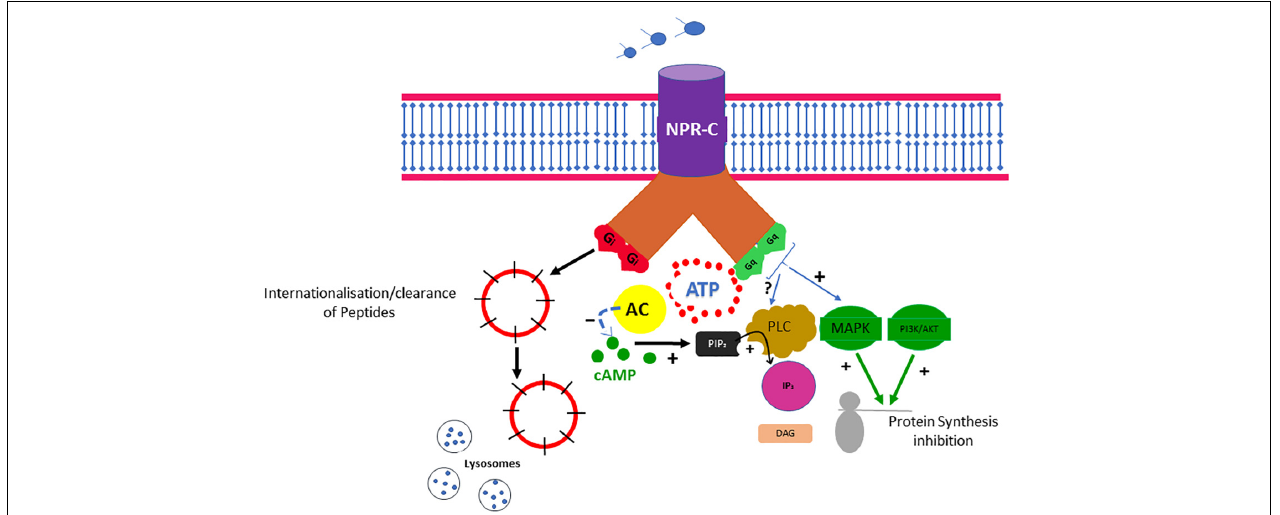
FIGURE 2 | Obesity and associated metabolic traits drive myocardial dysfunction and remodeling in obesity-HFPEF phenotype. Obesity and associated metabolic traits induce a systemic proinflammatory state characterized by high plasma levels of interleukin 6 (IL-6), soluble ST2 (sST2), tumor necrosis factor α (TNF- α ), and pentraxin 3. Coronary microvascular endothelial cells produce vascular cell adhesion molecule (VCAM), E-selectin, and reactive oxygen species (ROS). The production of ROS results in reduced NO bioavailability and peroxynitrite (ONOO − ) production, both of which may lower soluble guanylate cyclase (sGC) activity in adjacent cardiomyocytes. Lower sGC activity results in decreased cGMP concentration and reduced protein kinase G (PKG) activity. Low PKG activity may trigger a cascade of events leading to cardiomyocyte hypertrophy. E-selectin and VCAM expression in endothelial cells may favor migration into the subendothelium of immune cells, which may release cytokines and growth factors including the fibroblast growth factors (FGF-1 and FGF-2) and platelet-derived growth factor (PDGF). FGF-1, FGF-2, and PDGF activate the membrane tyrosine kinase receptors, which then trigger a full range of intracellular Ras-Raf–mitogen-activated protein kinase (MAPK)/extracellular signal–regulated kinase-MAPK signaling transduction pathways, leading to a down-regulation of NPR-C gene expression. Low NPR-C activity may remove the brake on cardiomyocyte hypertrophy, thereby inducing cardiac fibrosis and remodeling, leading to diastolic dysfunction, the major cardiac functional deficit in